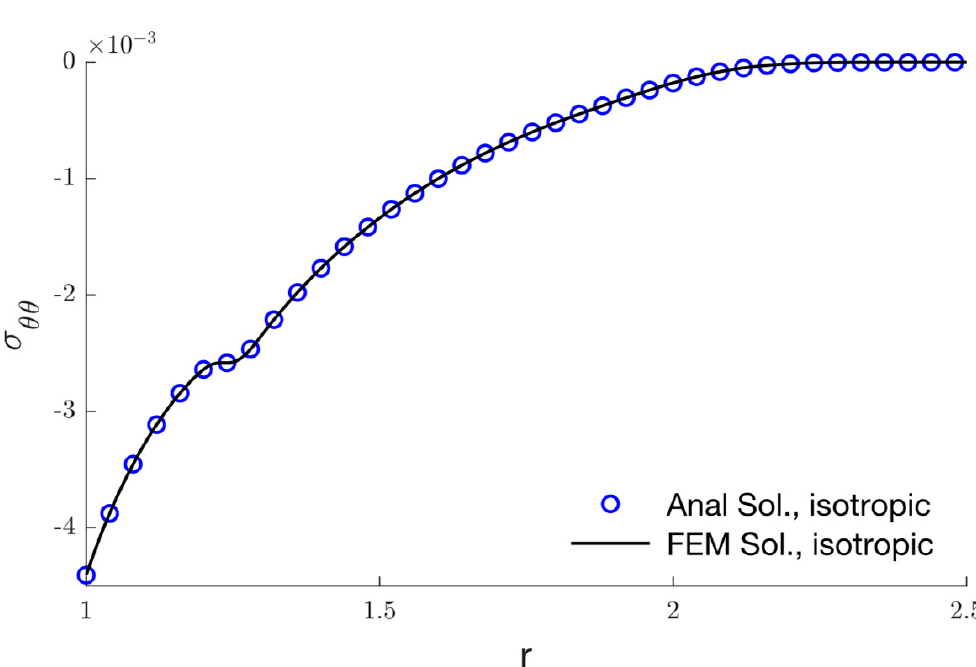
Figure 17. The shear stress variation 𝜎